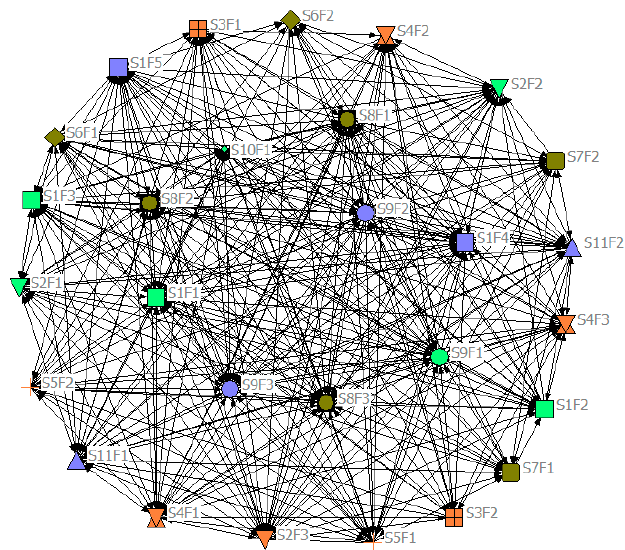
Figure 2. Stakeholder-associated influencing factor network.